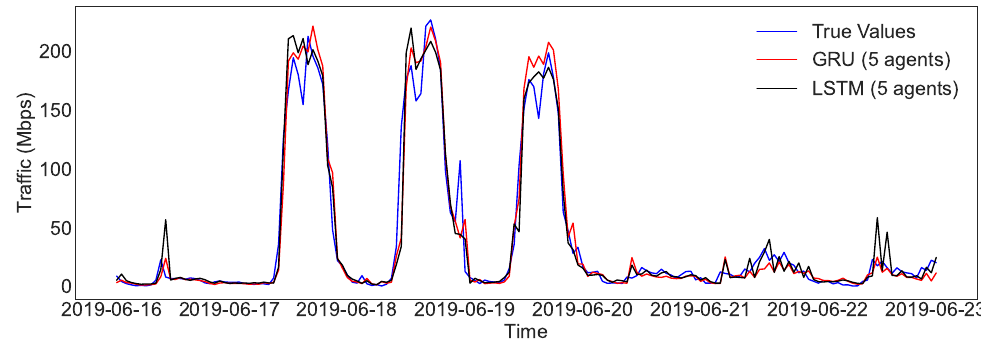
Figure 5. The comparison between true and predicted results for the first week in the test